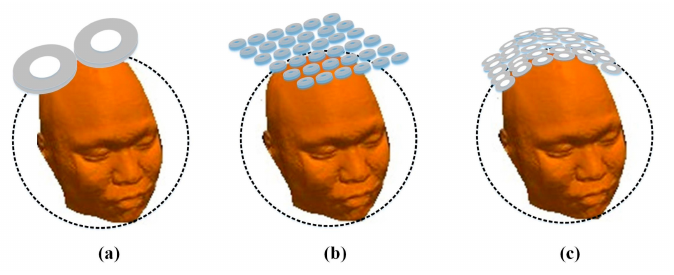
Figure 3. Coil arraysused forcomparison. ( a ) figure-8 coil; ( b ) 36-coilplanar array; ( c ) 36-coilcap-formed